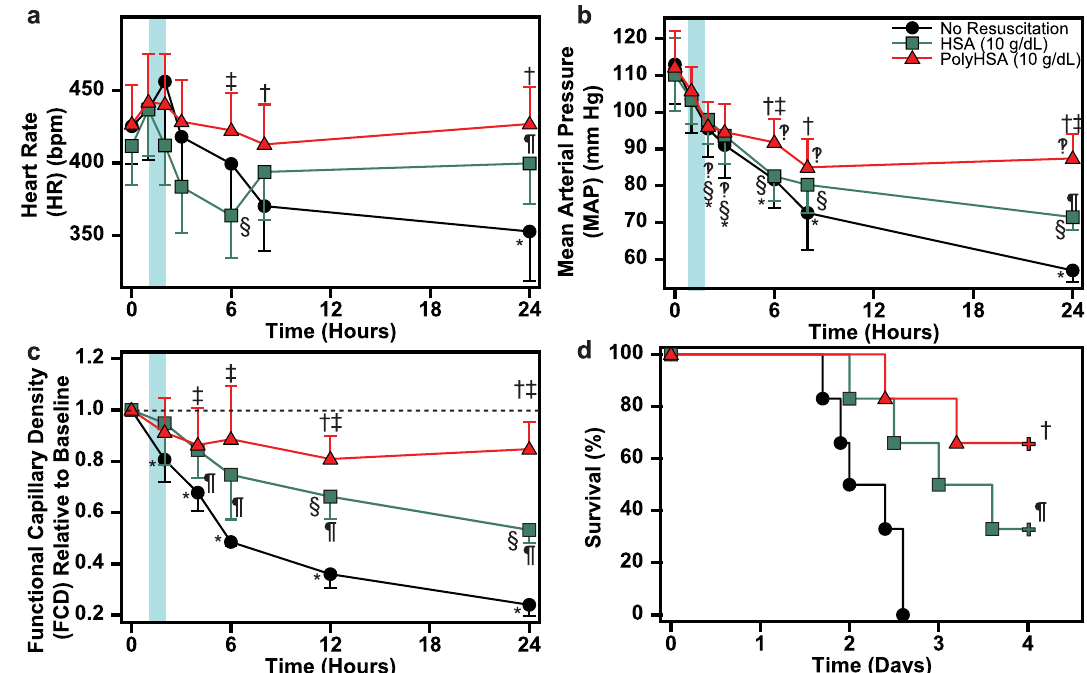
Figure 7. Changes in systemic hemodynamics, functional capillary density and survival following CLP induced polymicrobial sepsis. ( a ) Heart rate, ( b ) mean arterial pressure, ( c ) functional capillary density and ( d ) survival with no resuscitation, infusion of HSA, or infusion of PolyHSA. Data are presented as mean and SD. Survival was assessed via pairwise implementation of the log-rank test. † P < 0.05 between the PolyHSA and no resuscitation groups at the same time point. ‡ P < 0.05 between the PolyHSA and HSA groups at the same time point. ¶ P < 0.05 between the HSA and No resuscitation groups at the same time point. Symbols next to data points indicate a significant (P < 0.05) difference at that time point compared to baseline conditions for (*) no resuscitation, (§) HSA, and ( ‽ ) PolyHSA (n = 6